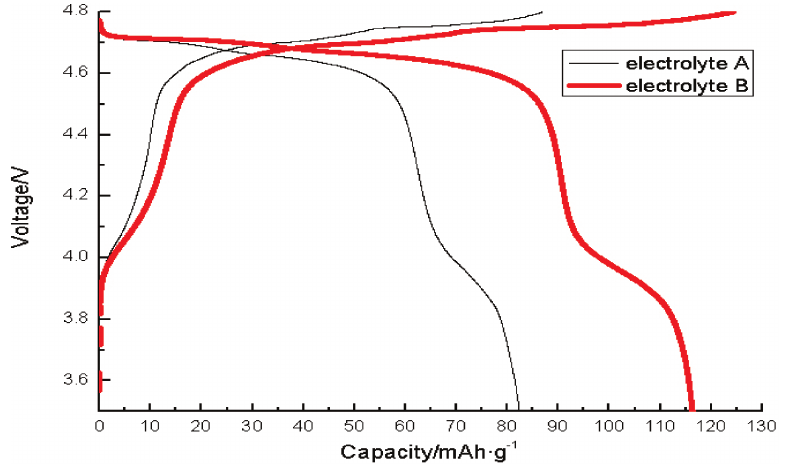
Fig. 5: Charge and discharge curves of LiNi 0.5 Mn 1.5 O 4 coin cells with two different kinds of electrolyte at 0.1C.